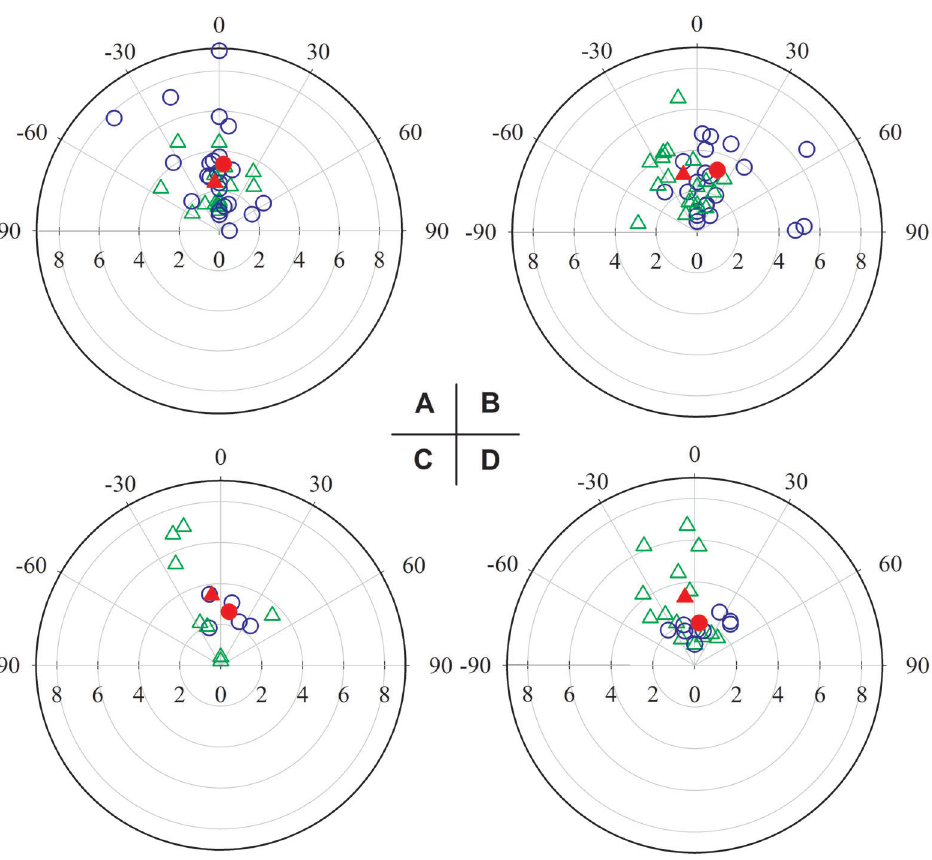
Figure 2. Performances of eight occluded conditions. Plots showing distances (cm) and angles ( u ) of individual strikes (unfilled symbols) and mean values (filled symbols) in the occlusion conditions: A: Binocular occlusion (blue unfilled circles and red filled circle) vs. bilateral pit organ occlusion (green unfilled triangles and red filled triangle). B: Left eye and pit occlusion (blue unfilled circles and red filled circle) vs. right eye-pit occlusion (green unfilled triangles and red solid triangle). C: Contralateral occlusion of the left eye and right pit organ (blue unfilled circles and red filled circle) vs. contralateral occlusion of the right eye and left pit organ (green unfilled triangles and red solid triangle). D: Unilateral opening of only the right pit (blue unfilled circles and red filled circle) vs. unilateral opening of only the left pit organ (green unfilled triangles and red filled triangle).